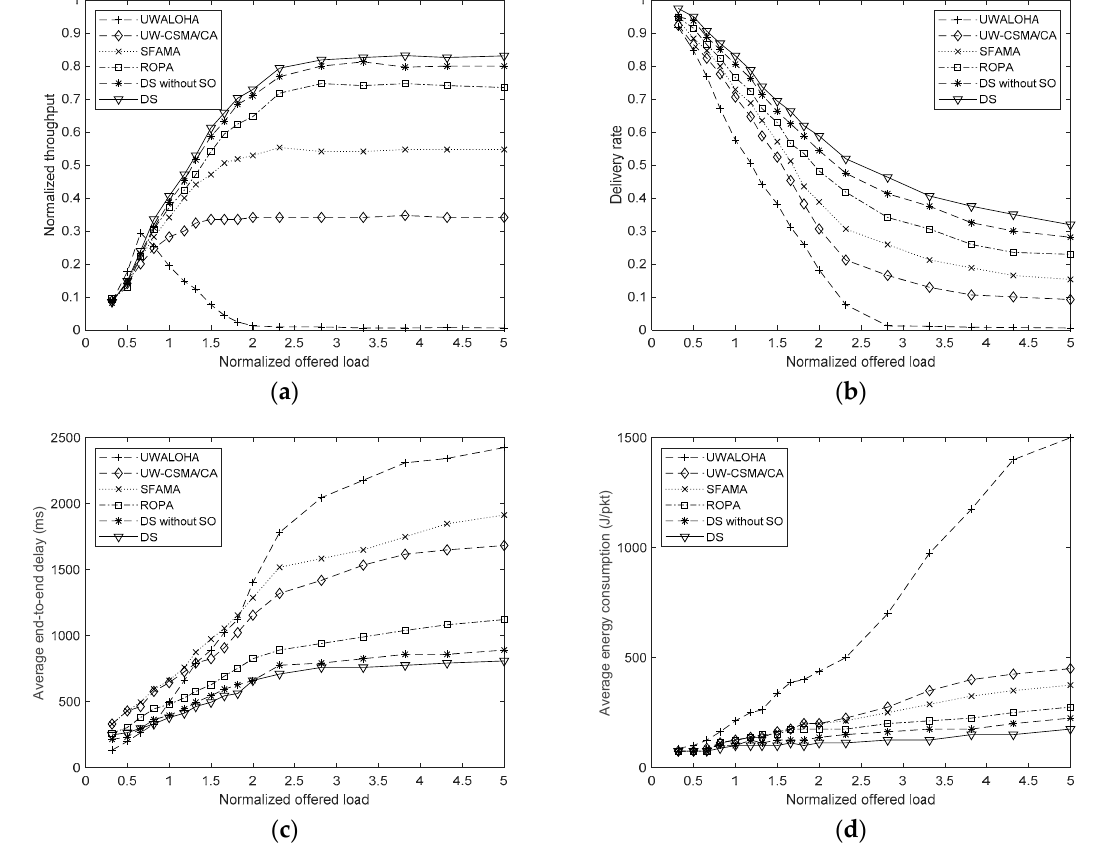
Figure 3. Performance of UWALOHA, UW-CSMA/CA, SFAMA, and ROPA protocols and that of the proposed method under different network loads. ( a ) Normalized throughput; ( b ) Packet delivery rate; ( c ) Average end-to-end delay; ( d ) Average energy consumption.